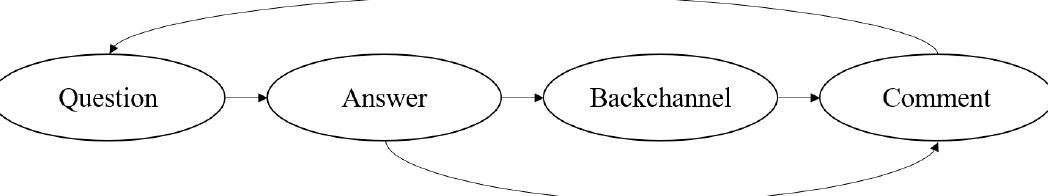
Figure 2. State transition diagram Of a dialogue with an elderly person. Table 1. State transition table of the state transition diagram. The events are abbreviated as